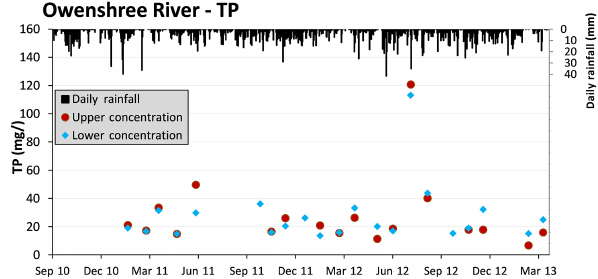
Figure 5. Daily rainfall and TN concentrations at the upper (U) and lower (L) sampling locations on the SA1 River.